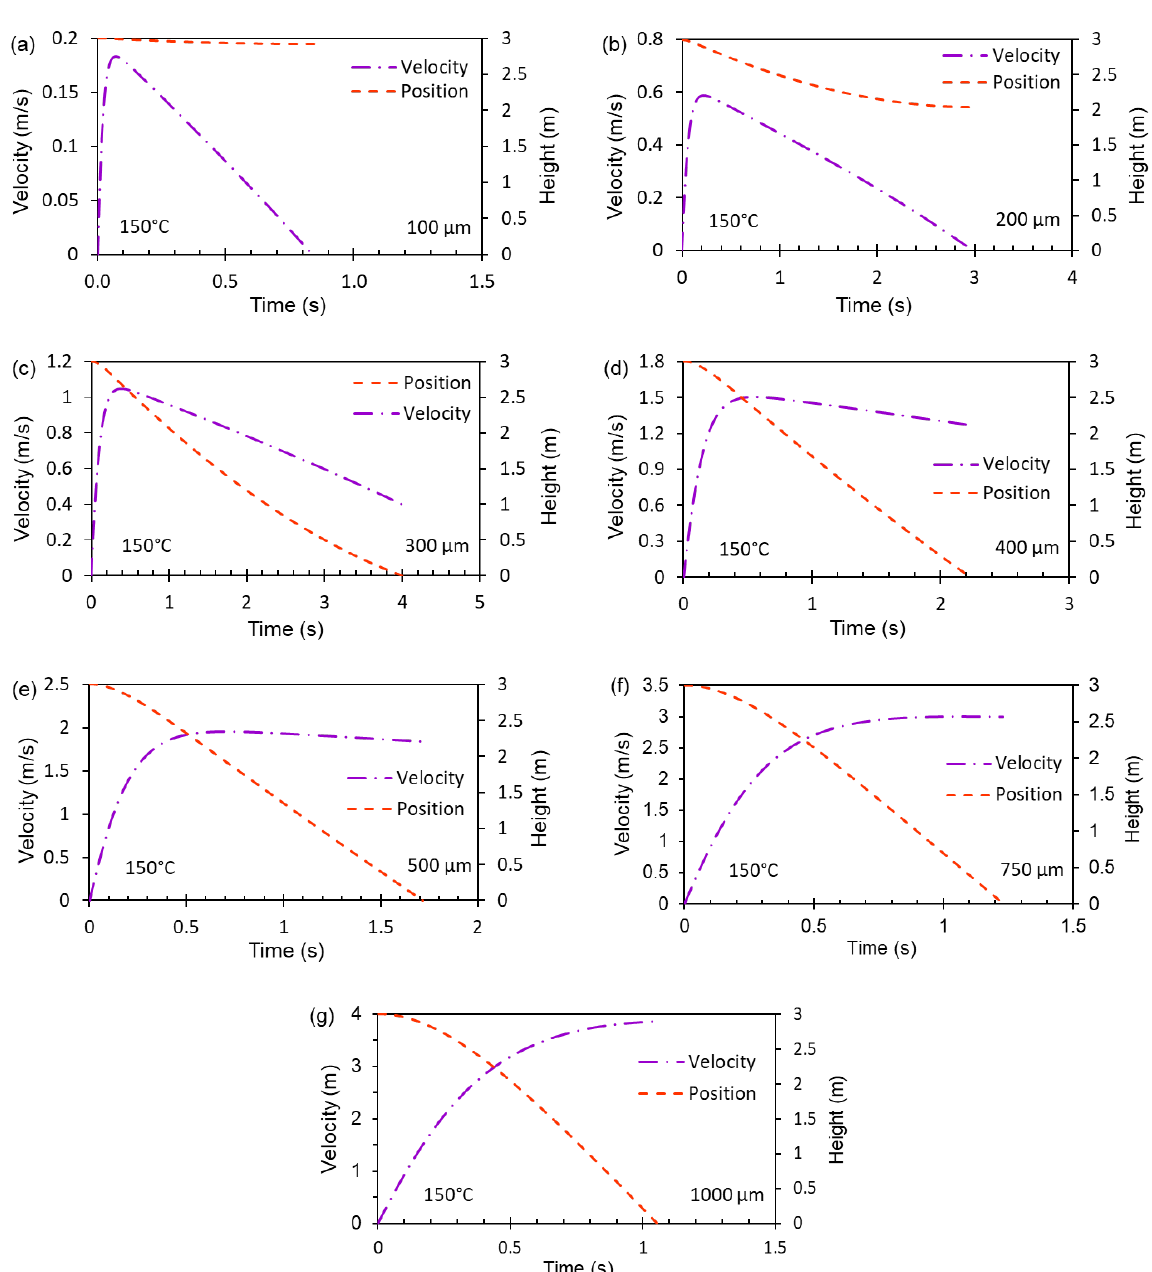
Figure 7. Velocity and position history of droplets with different initial drop sizes for condition 2 (150 °C); ( a ) 100 µm; ( b ) 200 µm; ( c ) 300 µm; ( d ) 400 µm; ( e ) 500 µm; ( f ) 750 µm; and ( g ) 1000 µm.